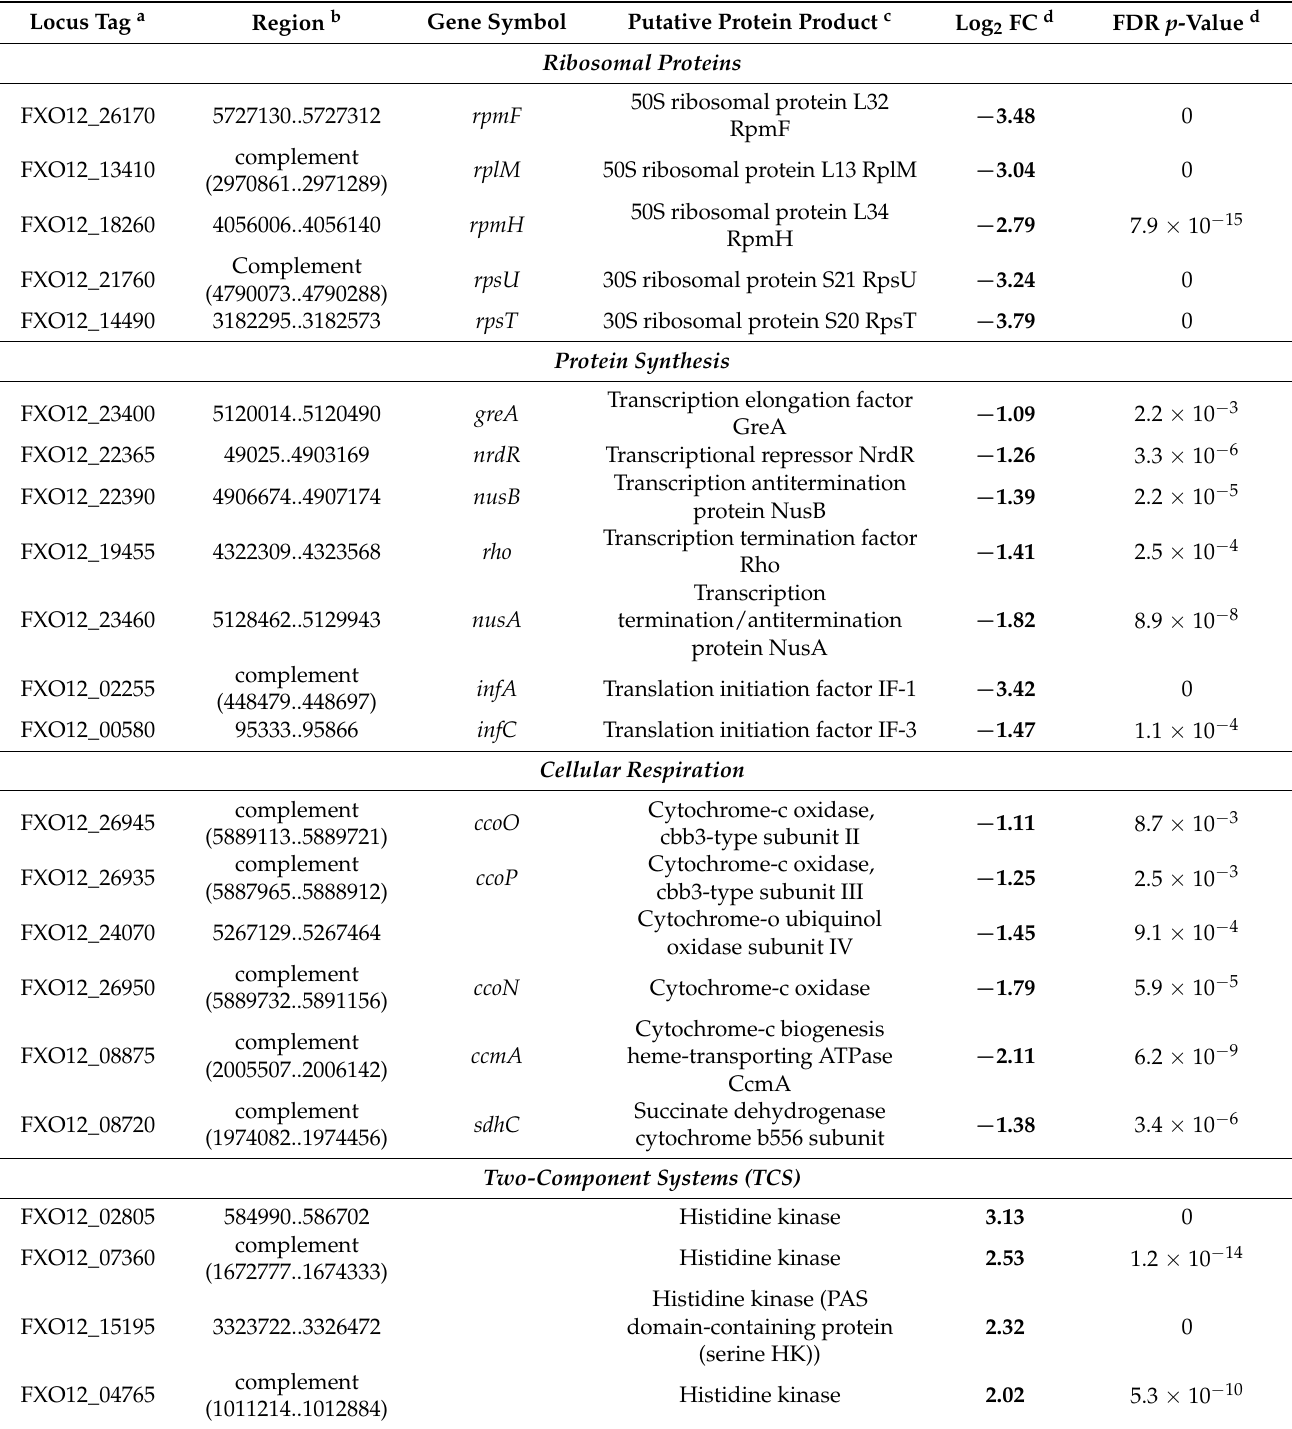
Table 3. Selected differentially-transcribed genes playing roles in different cellular processes (except those functioning primarily in iron